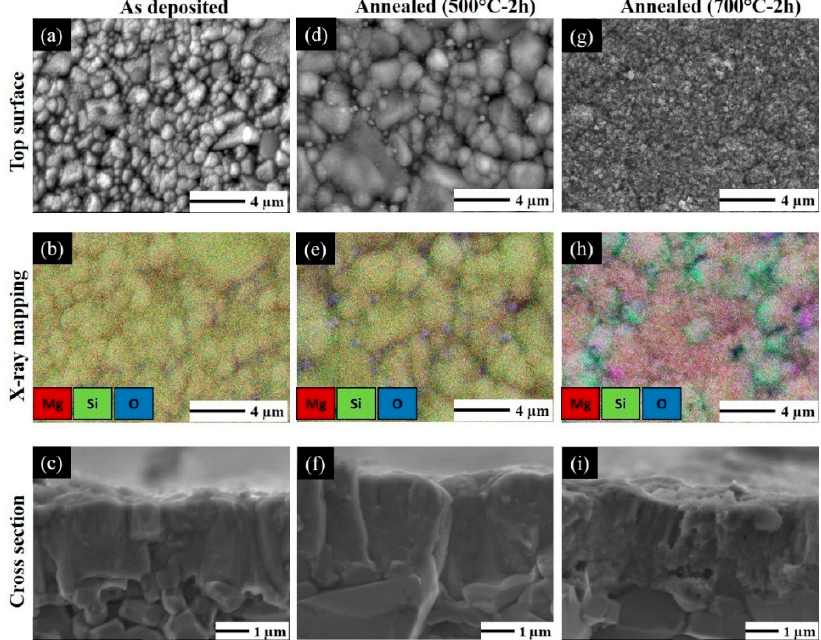
Figure 7. Top, X-ray mapping and cross-section observations of Mg 2 Si thin films with suitable composition in Group I ( R P < 7 × 10 − 4 Pa) deposited on alumina substrate; as-deposited ( a – c ); annealed for 2 h at 500 °C ( d – f ) and 700 °C ( g – i ) in air.